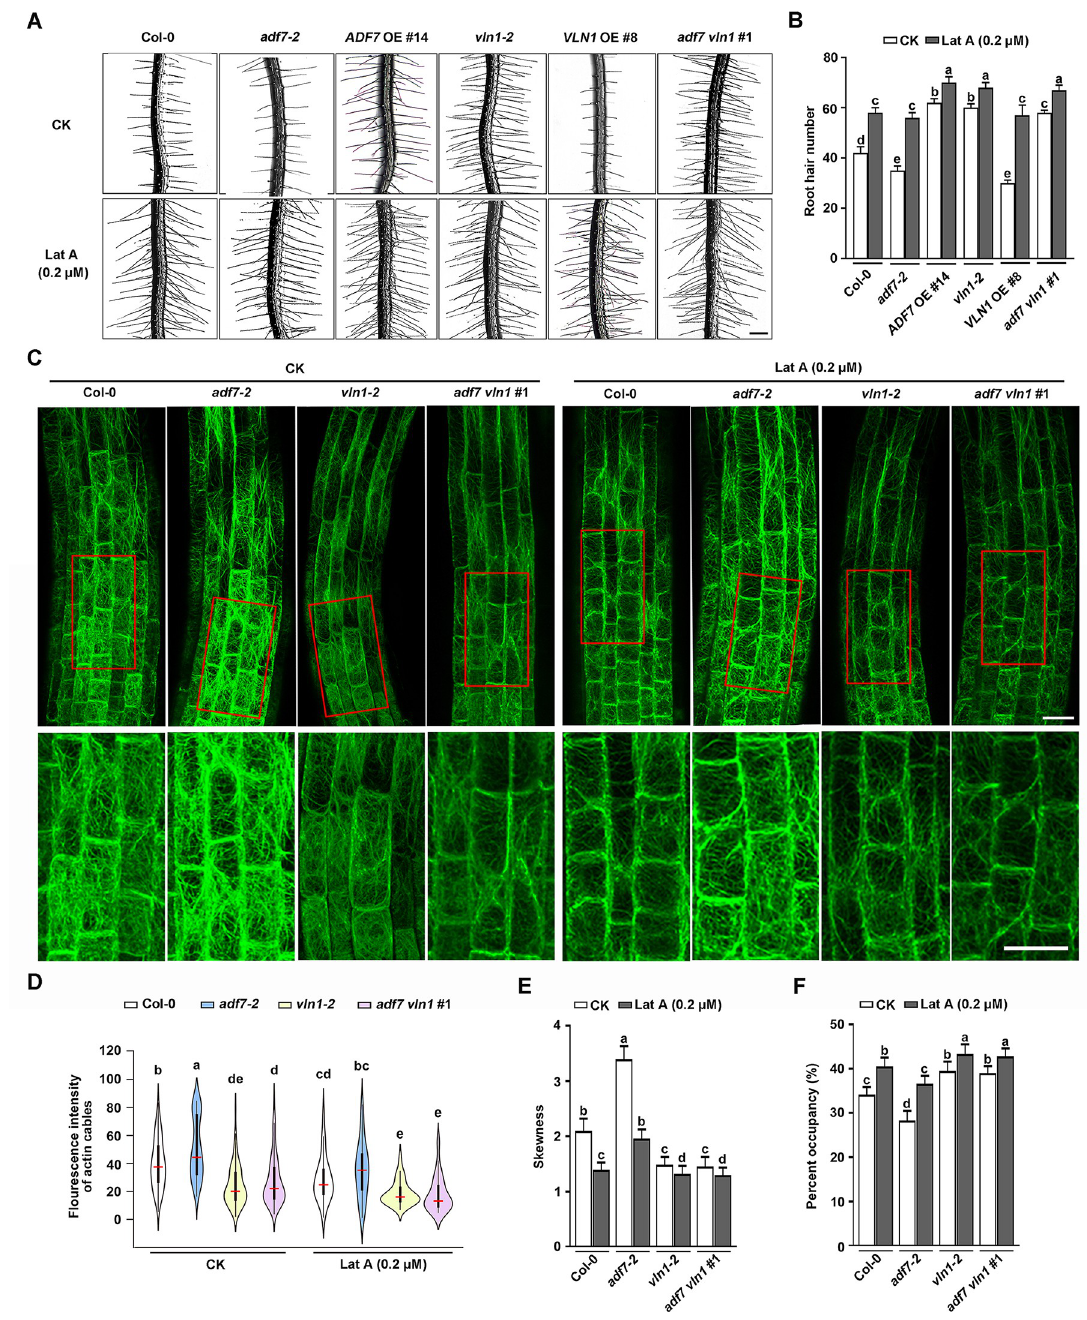
Fig 5. The F-actin depolymerization regulated by ADF7-inhibited-VLN1 promotes root hair formation. (A) Images of root hairs from Col-0, adf7-2 , ADF7 OE #14, vln1-2 , VLN1 OE #8, and adf7 vln1 #1 under CK and Lat A treatments (0.2 μ M). Scale bar, 200 μ m. (B) Histogram depicting root hair number in (A) . (C) Confocal microscopy images of epidermal cells visualized by the expression of fABD2 :: GFP in root apices from Col-0, adf7-2 , vln1-2 , and adf7 vln1 #1 seedlings under Lat A treatments (0.2 μ M). Enlarged views from the red boxes are in the bottom row. Scale bar, 25 μ m. (D) Violin plot showing the average and contribution of fluorescence intensity of actin cables in (C) . The red line represents the average fluorescence intensity in different genotypes. (E) Histogram depicting skewness of F-actin in (C) . (F) Histogram depicting the percentage of occupancy of F-actin in (C) . Significant difference ( P < 0.05) indicated by different letters among genotypes is determined for each condition by one-way ANOVA followed by Tukey’s test in (B) , (D) , (E), and (F) .